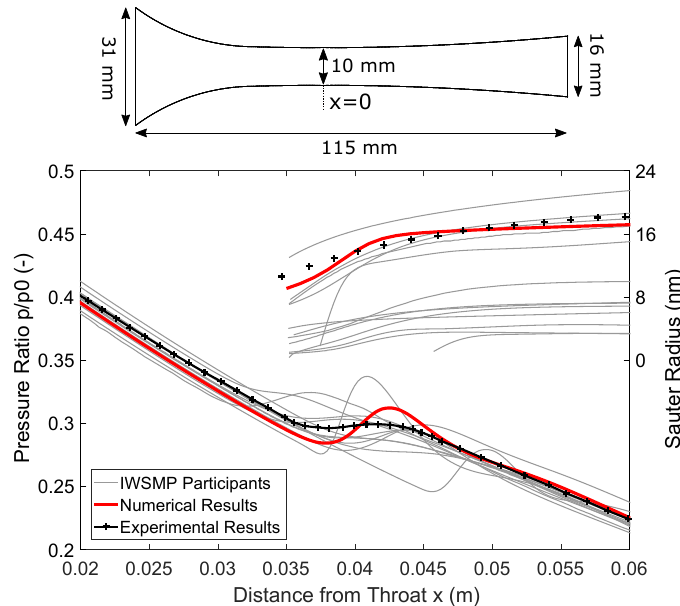
Figure 2. Validation with the Moses and Stein